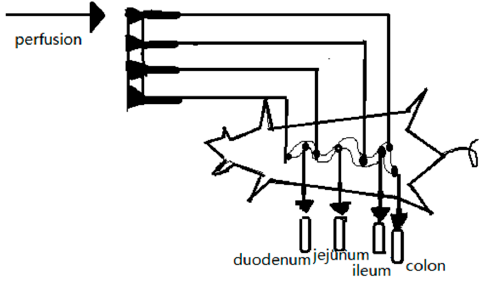
Figure 6. Schematic diagram of intestinal perfusion.